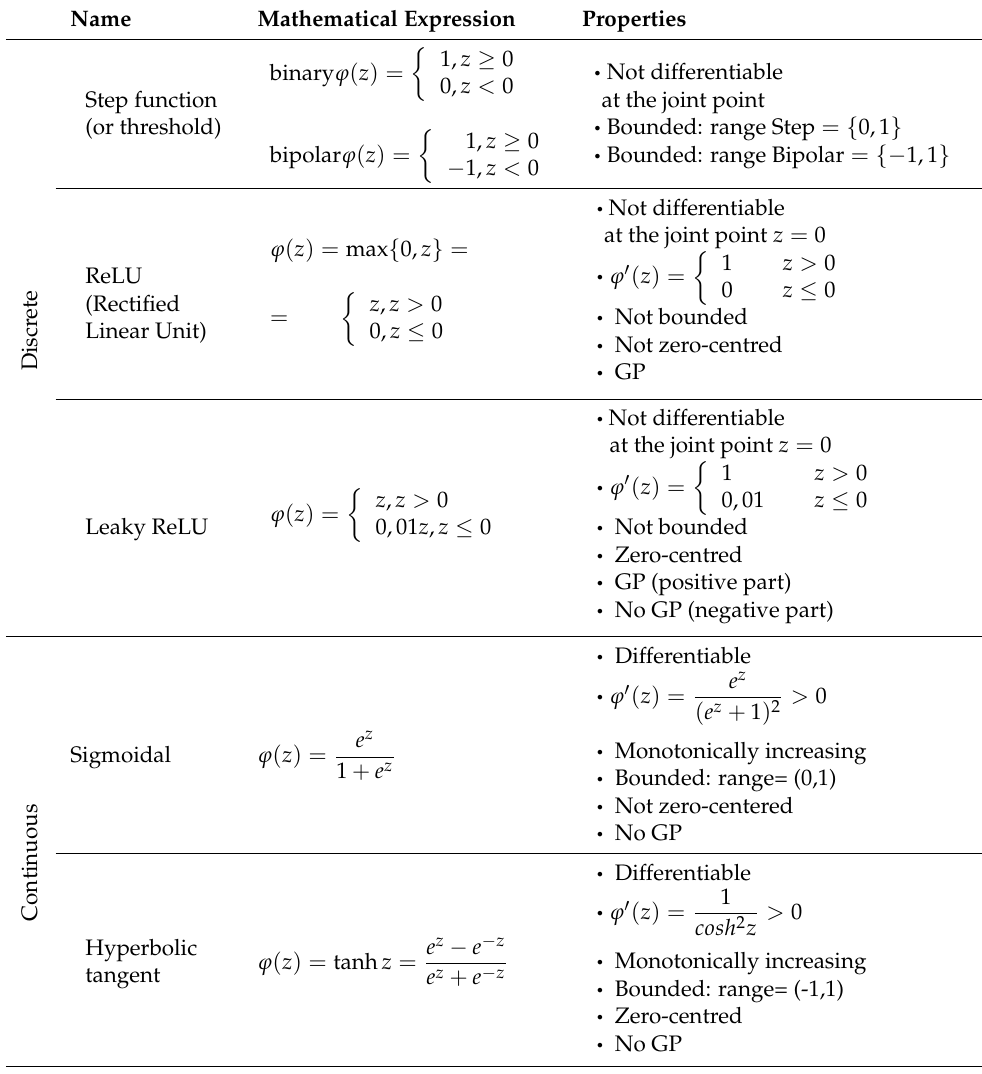
Table 1. Mainly used activation functions and their